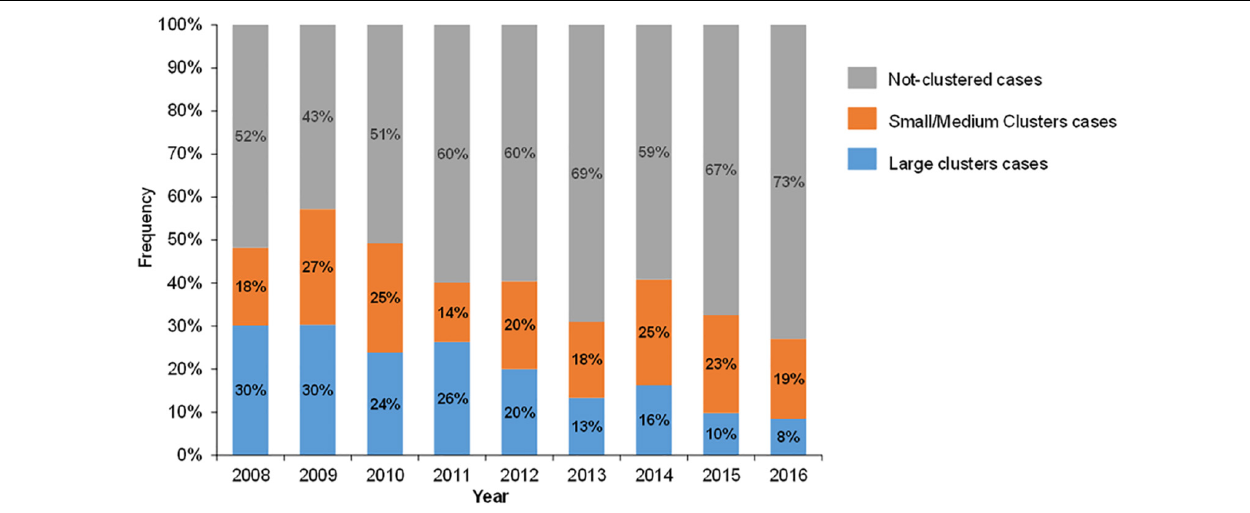
FIGURE 2 | Composition of newly diagnosed HIV-1–infected cases. Blue, orange, and gray columns represent cases belonging to large clusters ( ≥ 10 cases), small/medium clusters (2–9 cases), and cases not in a cluster, respectively.